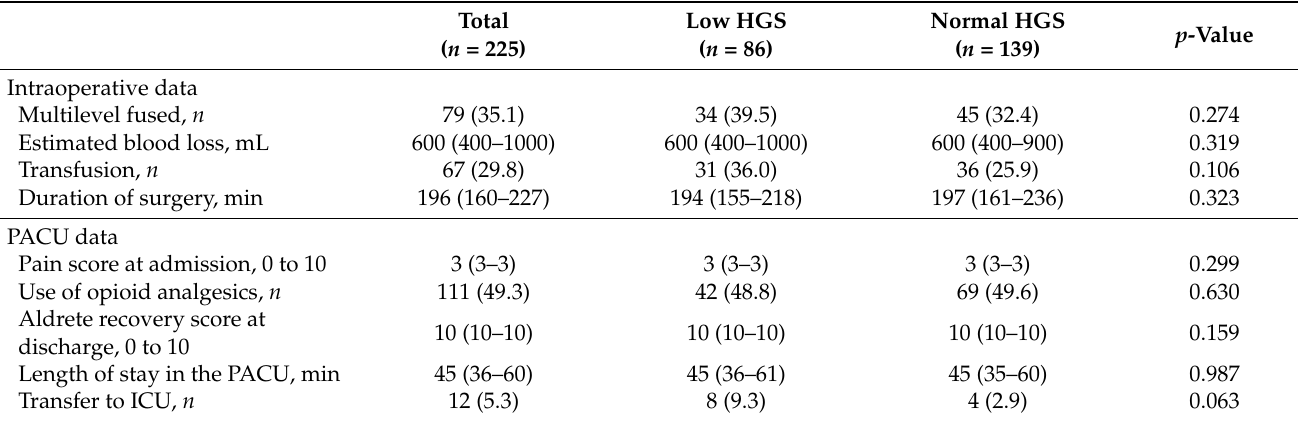
Table 2. Intraoperative and post-anesthetic care unit